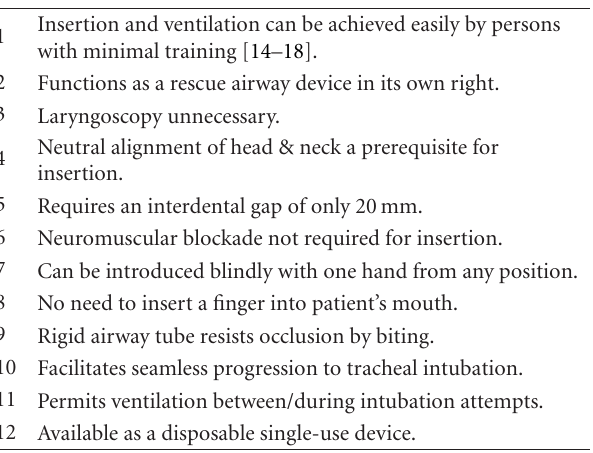
Table 2: Advantages of the iLMA for emergency prehospital